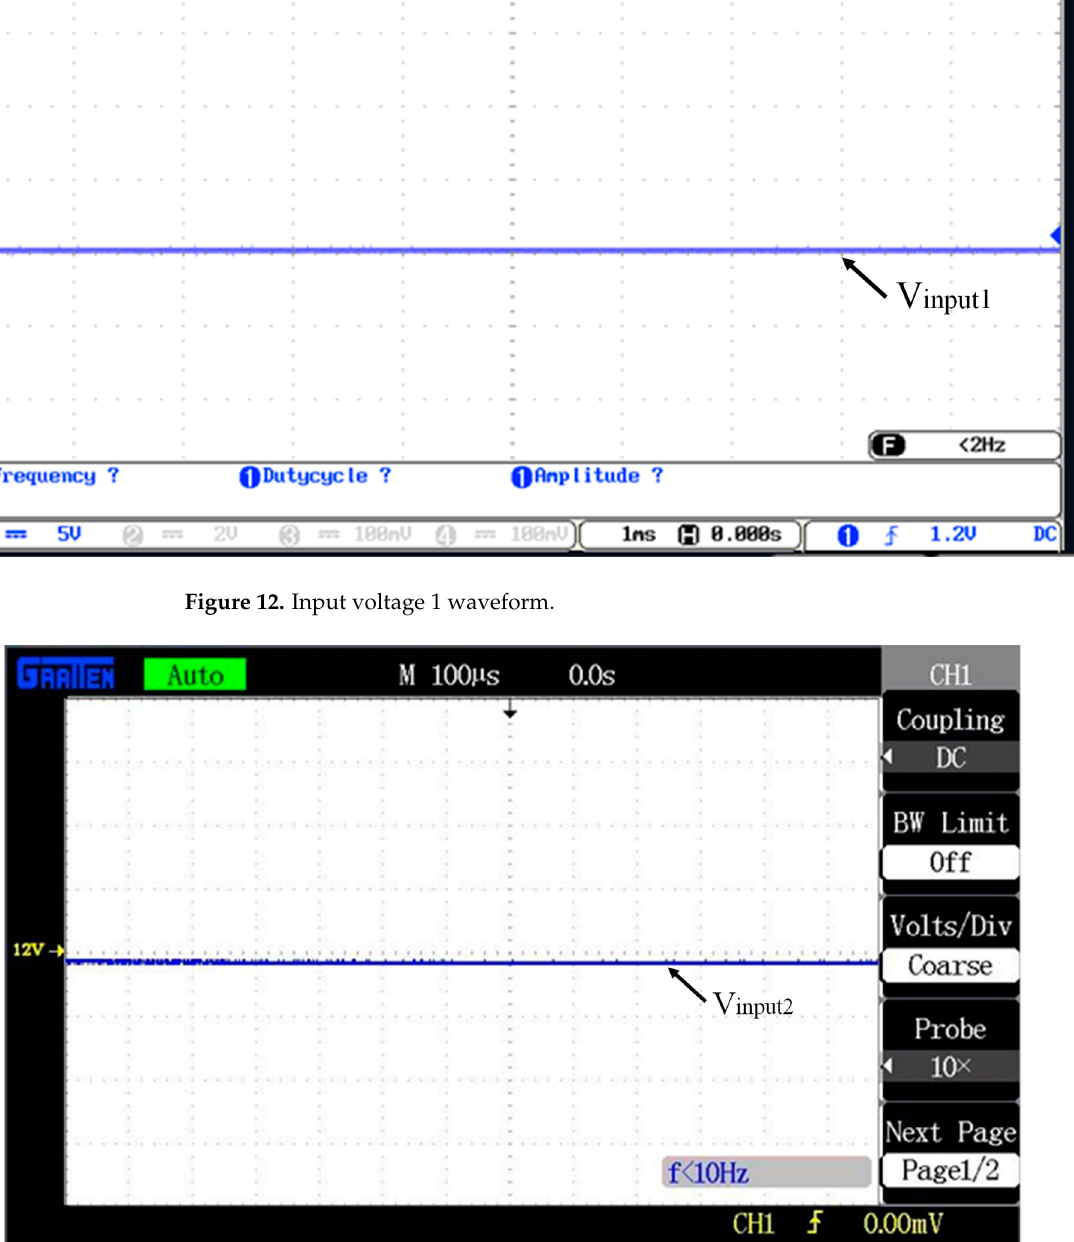
Figure 13. Input voltage 2 waveform.